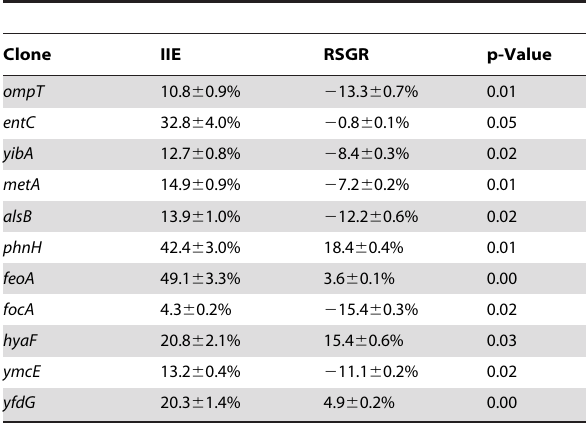
Table 3. Genes that significantly increase n-butanol tolerance when they are overexpressed using ASKA